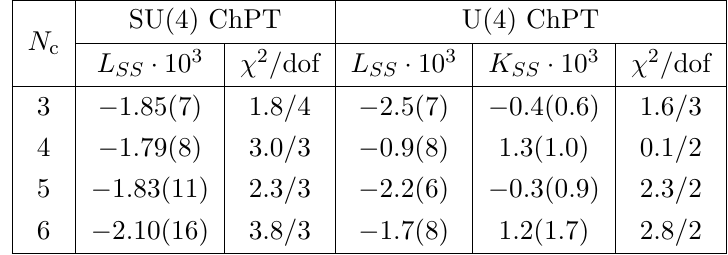
Table 5 . Results of fits of ∆ E SS to SU(4) and U(4) ChPT at fixed N c . N c = 3 ensembles with ξ & 0 . 14 are not fitted.